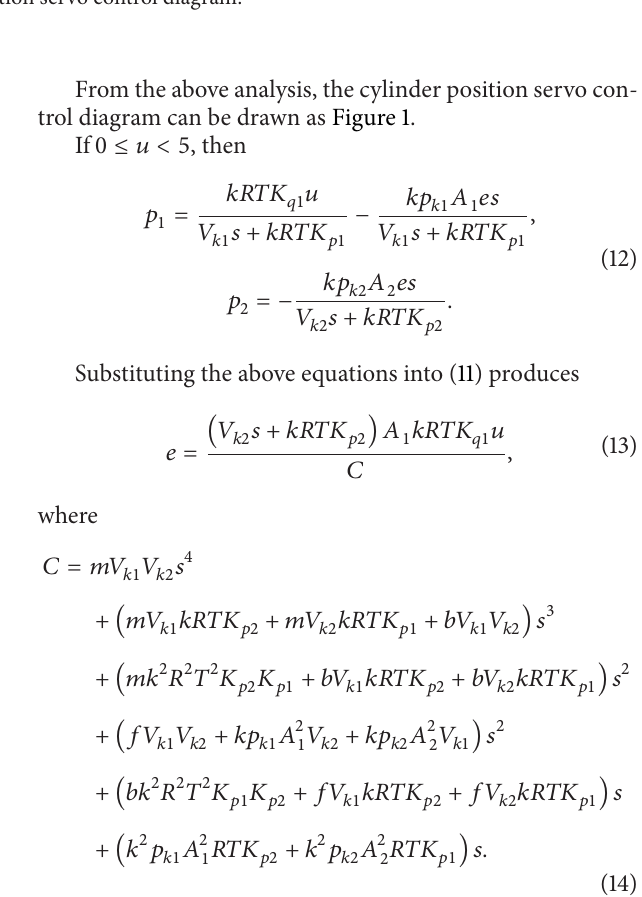
Figure 1: Cylinder position servo control